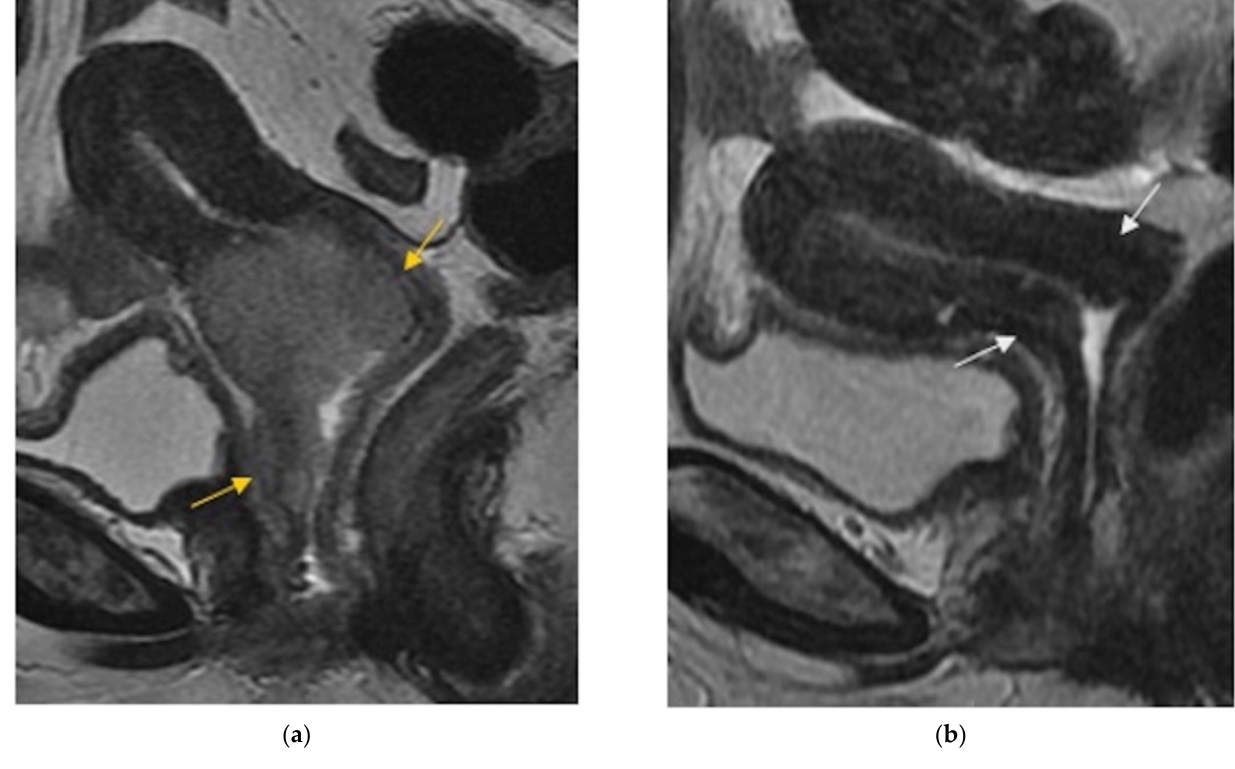
Figure 1. ( a ) Sagittal FSE T2-weighted image shows soft tissue with high signal intensity consistent with a cervical tumor extended to the vagina (arrows). ( b ) Sagittal FSE T2-weighted image shows reconstitution of the normal T2-weighted hypointense cervical stroma (arrows), with disappearance of the tumoral mass after chemoradiation therapy. Table 2. Different types of recurrences.